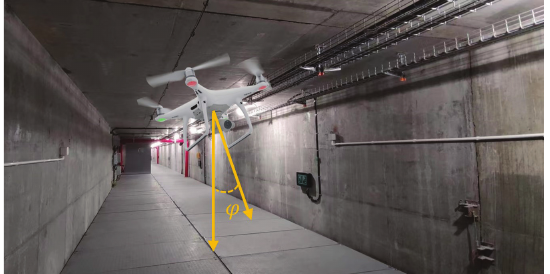
Figure 1. Quadrotor UAV control in limited space for tunnel healthy